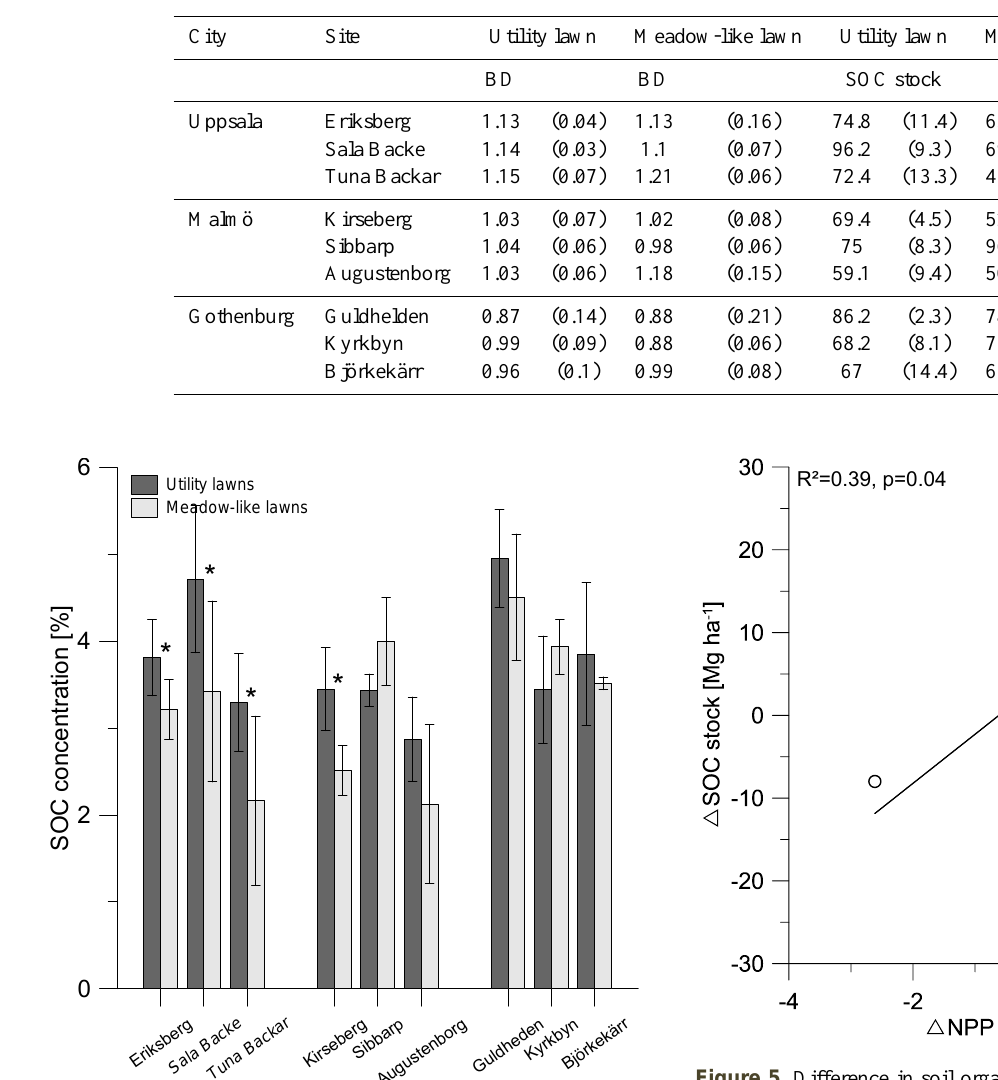
Table 2. Soil bulk density (BD) [gcm − 3 ] and SOC stocks [Mg ha − 1 ] according to Eq. (3). Standard deviation is given in brackets.